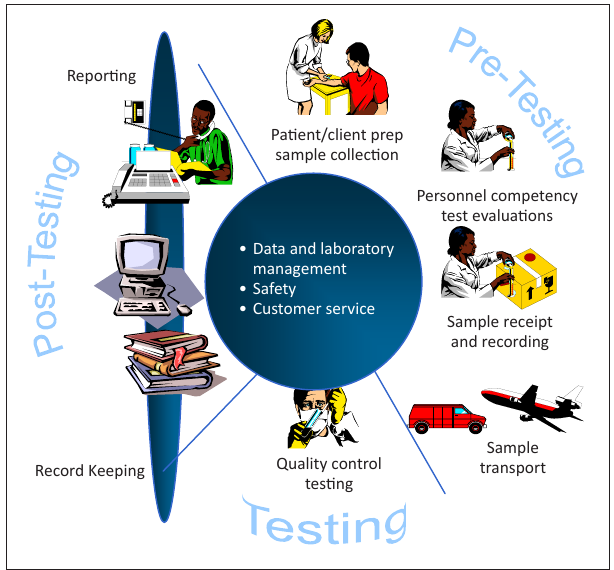
FIGURE 1: Model quality assurance